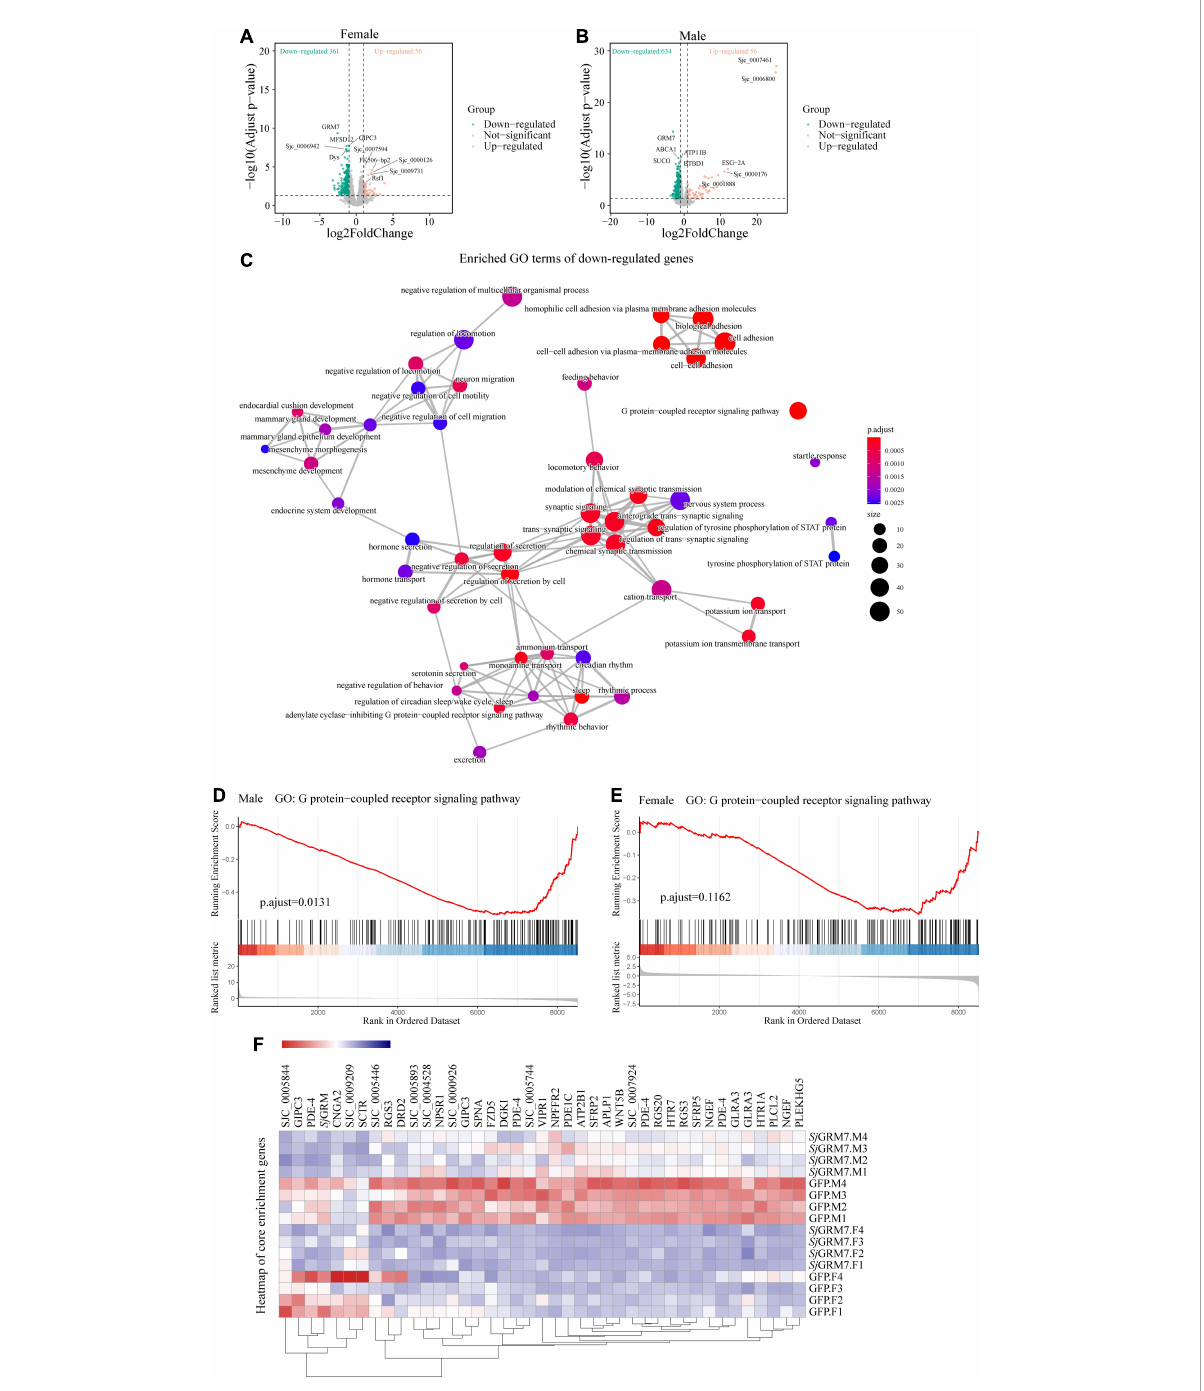
FIGURE6 Differentially expressed genes (DEGs) of S. japonicum after Sj GRM7 RNAi in vitro and gene ontology (GO) analysis. (A) DEG volcano plots in females and males. (B) X -axis: log 2 -fold change (ds Sj GRM7/GFP). Y -axis: log 10 (adjusted p -value). Green points represent significantly downregulated genes, and orange points represent significantly upregulated genes. (C) GO term visualization (enrichment calculated using gene-set enrichment analysis, p < 0.05, adjusted for FDR, only shown in genes significantly downregulated after Sj GRM7 knockdown). (D) GSEA showed downregulation of the GPCR signaling pathway in Sj GRM7 dsRNA group male worms and female worms (E) as compared to GFP controls. (E) Heat map of core enrichment genes in both males and females for the GPCR signaling pathway gene set. (F) The score at the peak of the plot (D,E) is the enrichment score (ES) for this gene set, and genes that appear before or at the peak are defined as core enrichment genes for this gene set. GFP, green fluorescent protein; dsRNA, double-stranded RNA; GRM, metabotropic glutamate receptor; GPCR, G protein-coupled receptor; GSEA, Gene set enrichment analysis; FDR, false discovery